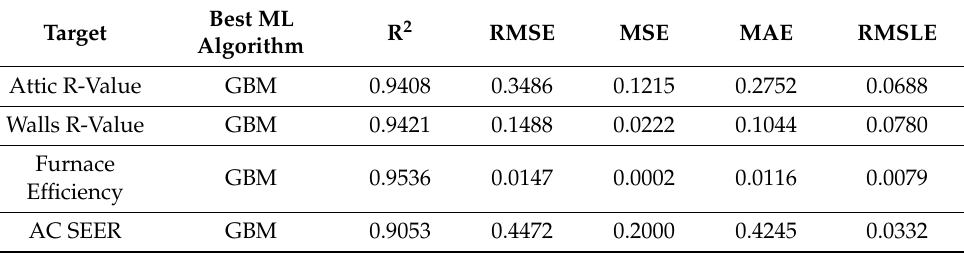
Table 7. Testing prediction evaluation statistics for the best model case from Table